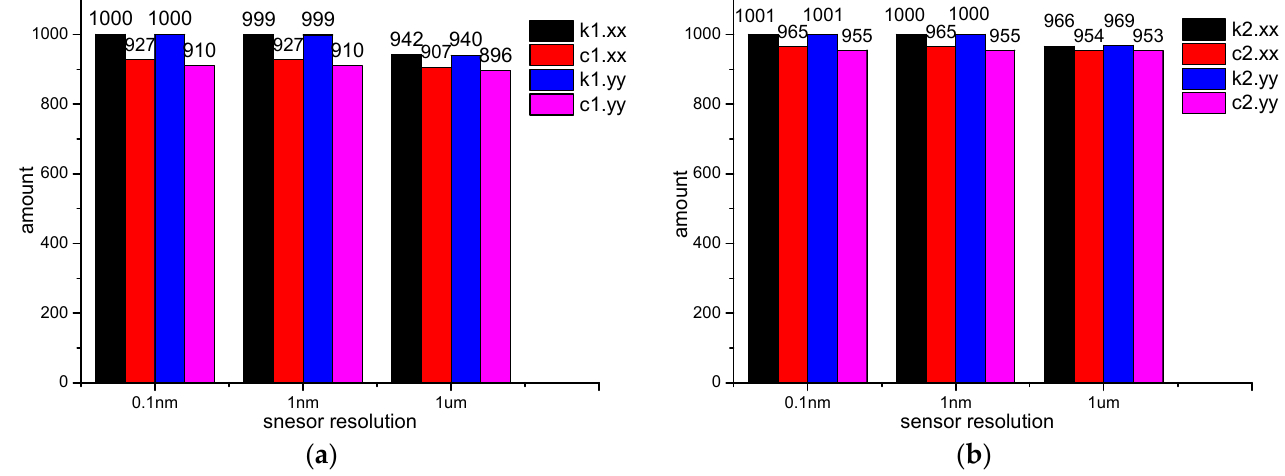
Figure A8. Statistical results of the amount of the frequencies, at which the related error is less than 10%: ( a ) #1 bearing; ( b ) #2 bearing.